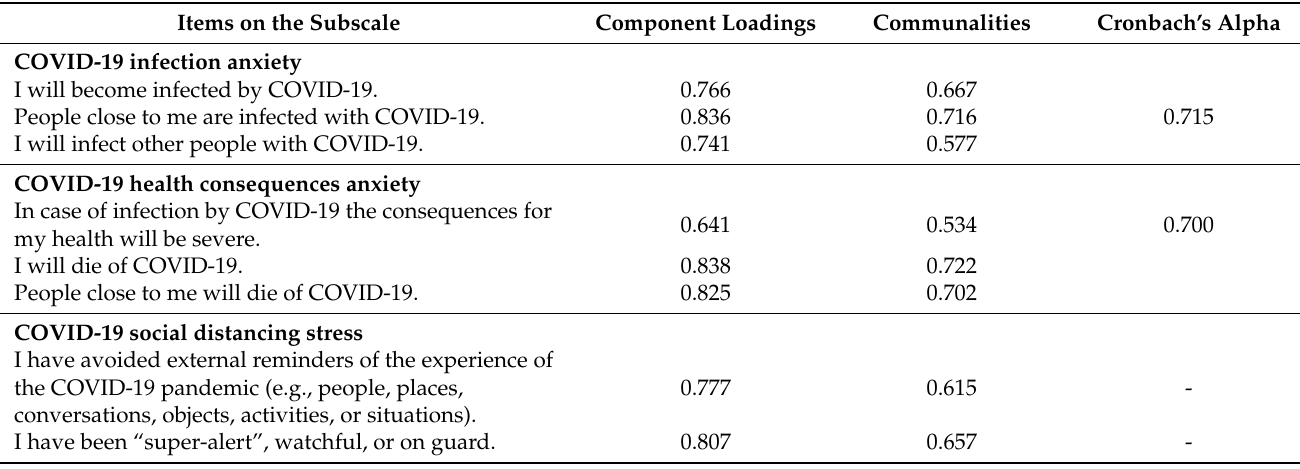
Table 6. Final items, factor loadings, commonalities and Cronbach’s alpha of the subscales in the